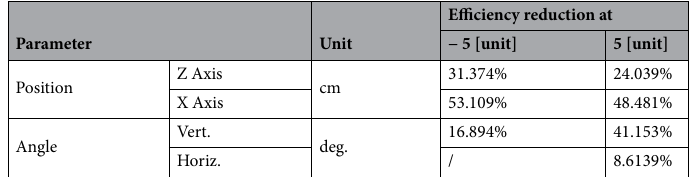
Table 5. System sensitivity summary, at 5.8GHz . The efficiency reduction for each parameter is a comparison between the maximum value and that at the specified variation, for each parameter sweep.